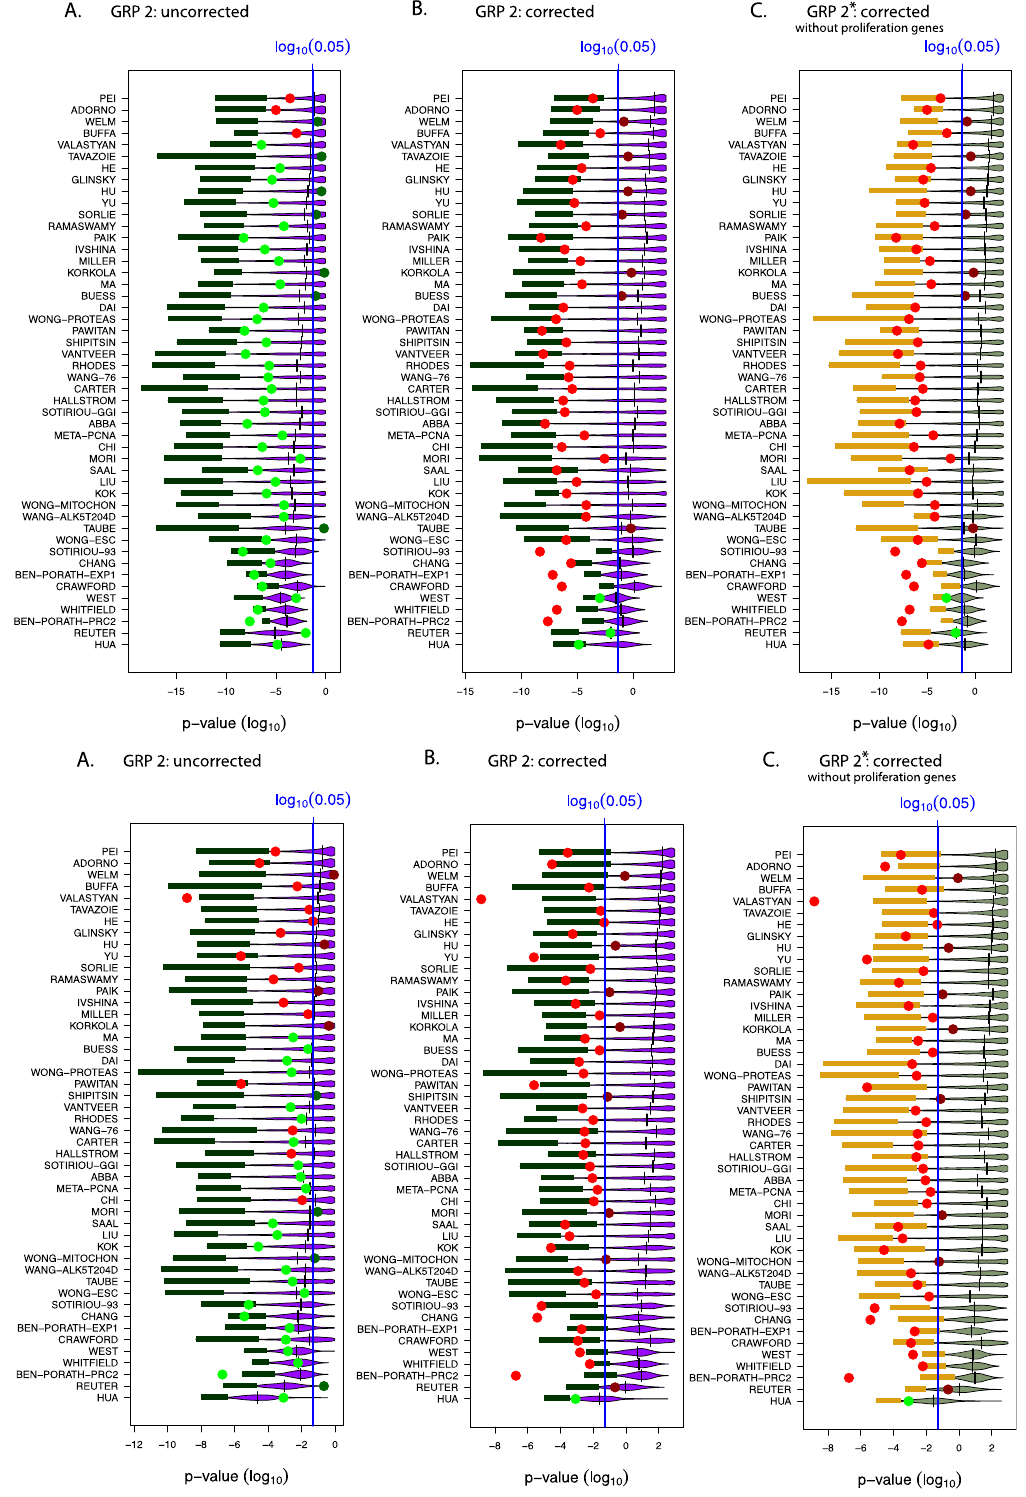
Figure 7. Results for gene removal procedure 2 and the SWE data similar to Fig. 6. Top row: Patient samples contain LumA, LumB, Basal and Her2. Bottom row: Patient samples contain LumA and